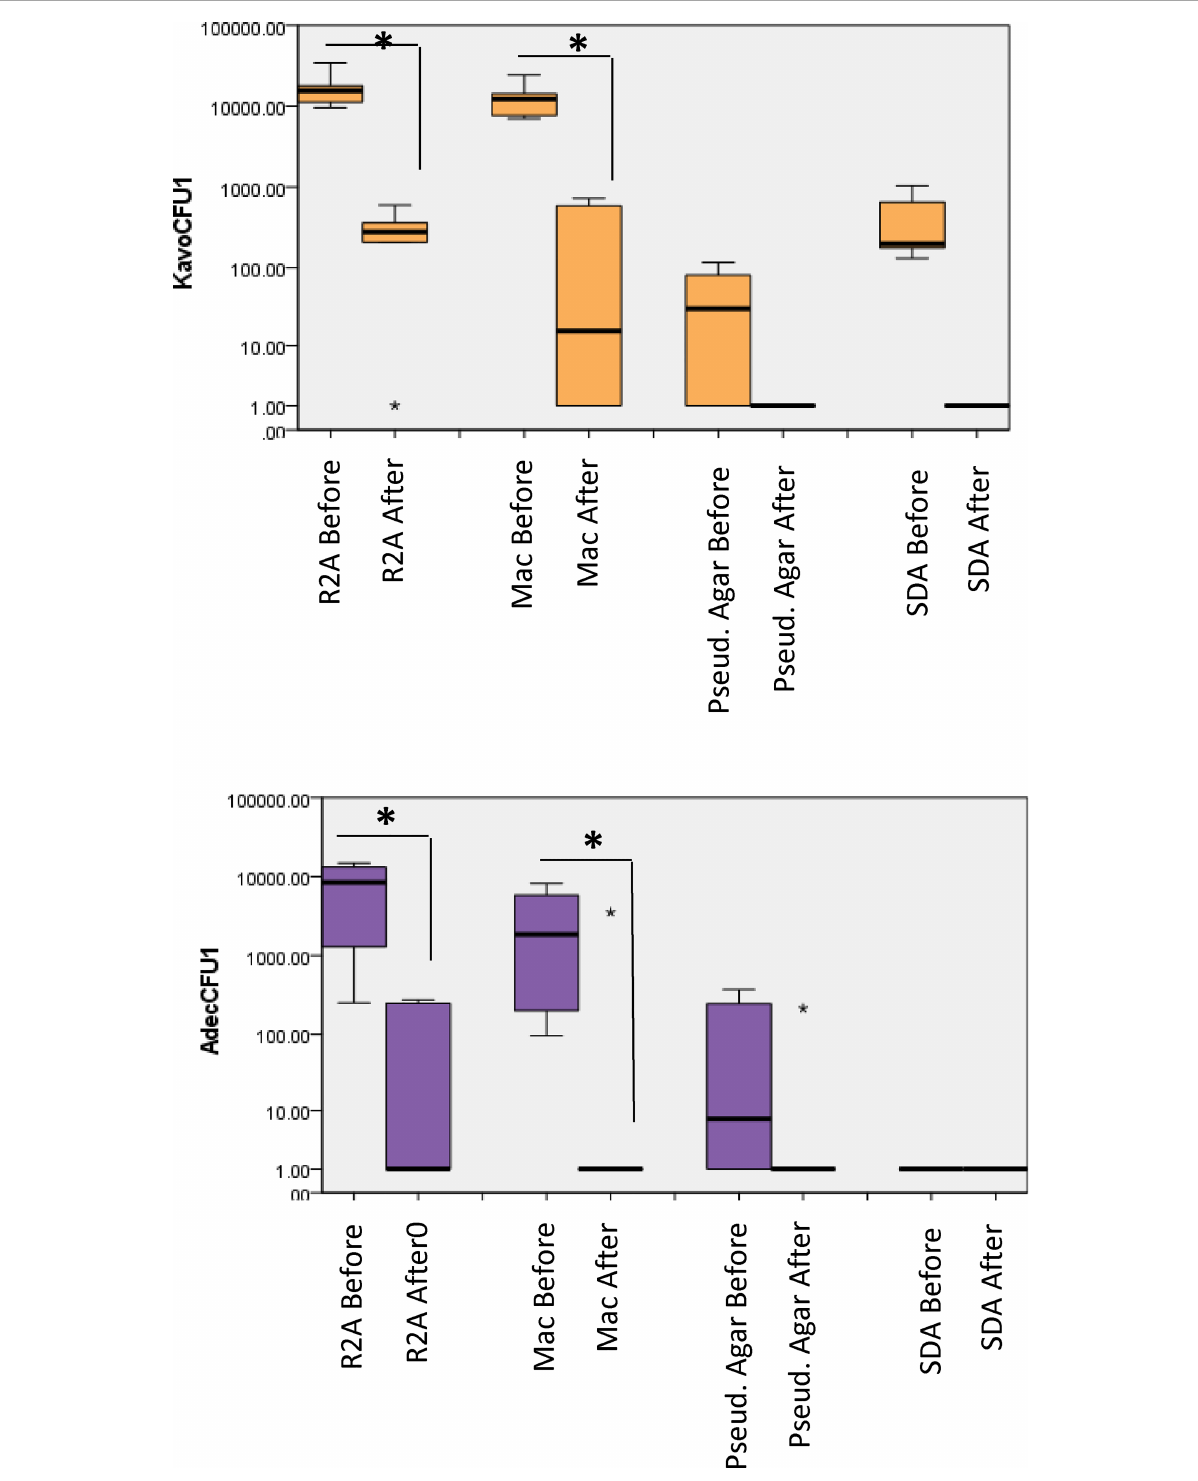
FIGURE 3 Total viable counts from water samples collected from dental unit water storage bottles. Samples were collected before and after treatment, 10-fold serially diluted up to 10 − 5 and plated on different culture media. The plates were then incubated in different atmospheric conditions for different incubation times as described in “ methods ” . P <0.05 Mann Whitney